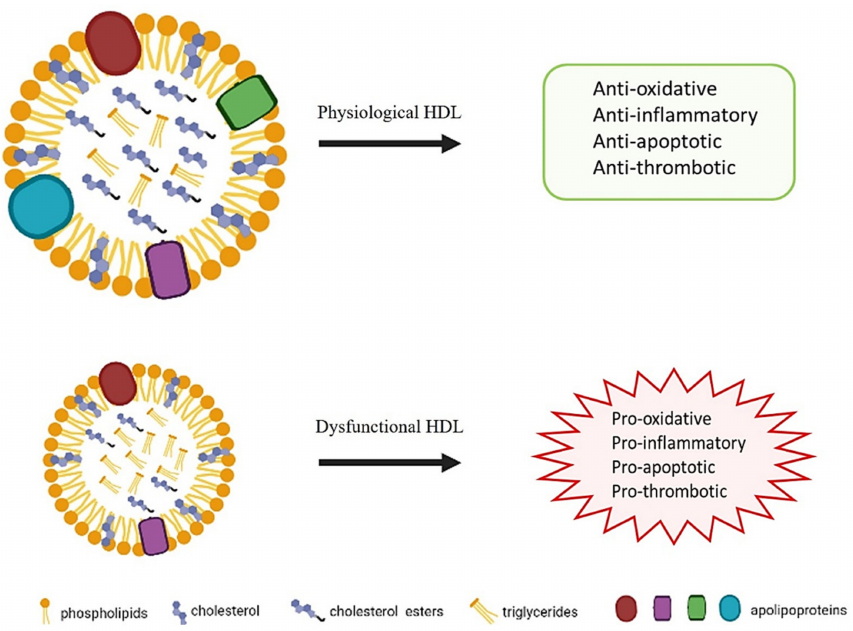
Figure 1. Properties of HDL in physiological and dysfunctional